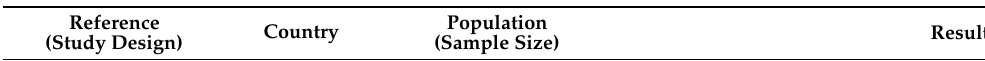
Table 8. Results on eating